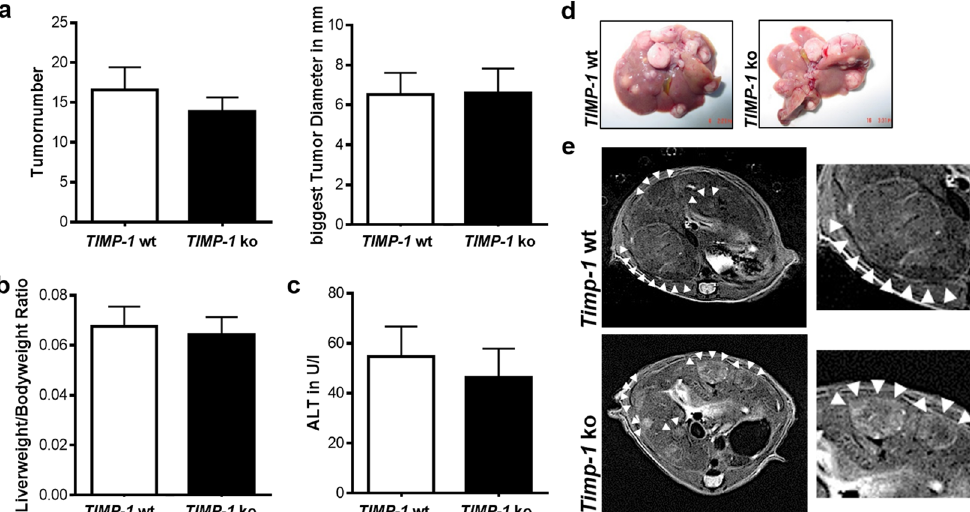
Figure 4. TIMP-1 deficient mice are not protected from hepatic carcinogenesis. Liver carcinogenesis was induced via juvenile DEN injection. ( a ) No differences between TIMP-1 wt and ko could be observed in tumor number or size. ( b ) TIMP-1 wt and ko show the same liverweight/bodyweight ratio. ( c ) ALT level were not induced following DEN treatment and did not differ between TIMP-1 wt and TIMP-1 ko. ( d ) Representative pictures of excised livers and ( e ) in vivo MRI images show equal tumor load of livers. Bar columns represent mean ± standard error of the mean. (n =